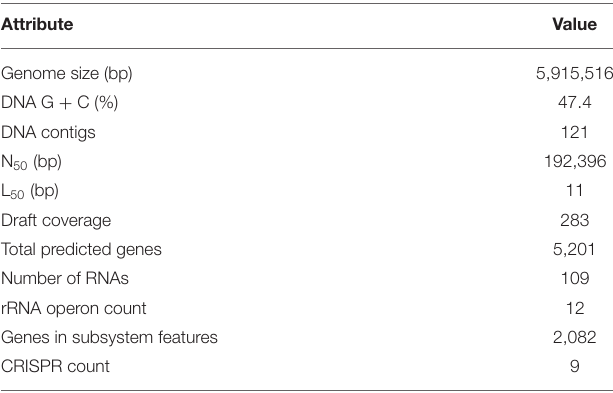
TABLE 6 | Nucleotide and gene count levels of the genome of Pseudoalteromonas sp. PPB1. Attribute